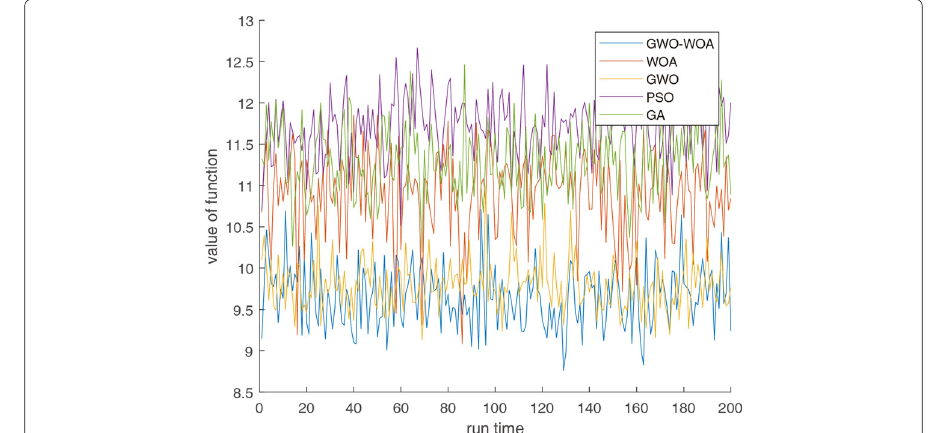
Fig. 4 The results of each run time of algorithms when device number is